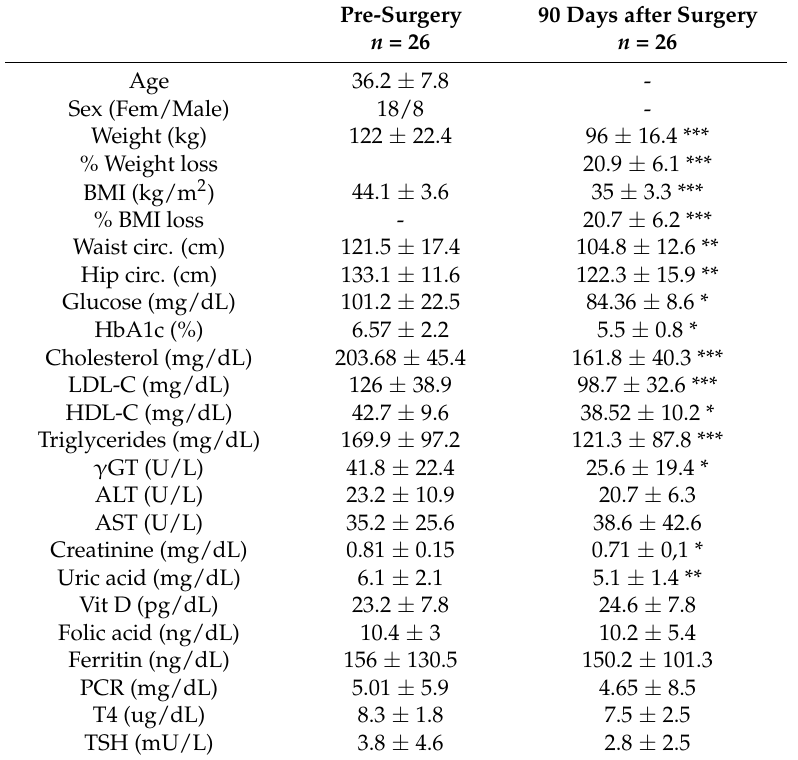
Tabagism Low-grade/moderate steatosis 17 Only two patients took more than 2 medications. Around 50% of the volunteers did not use any medication. Table 2. Clinical data before and 90 days after RYGB surgery. * p < 0.05, ** p < 0.01, *** p <